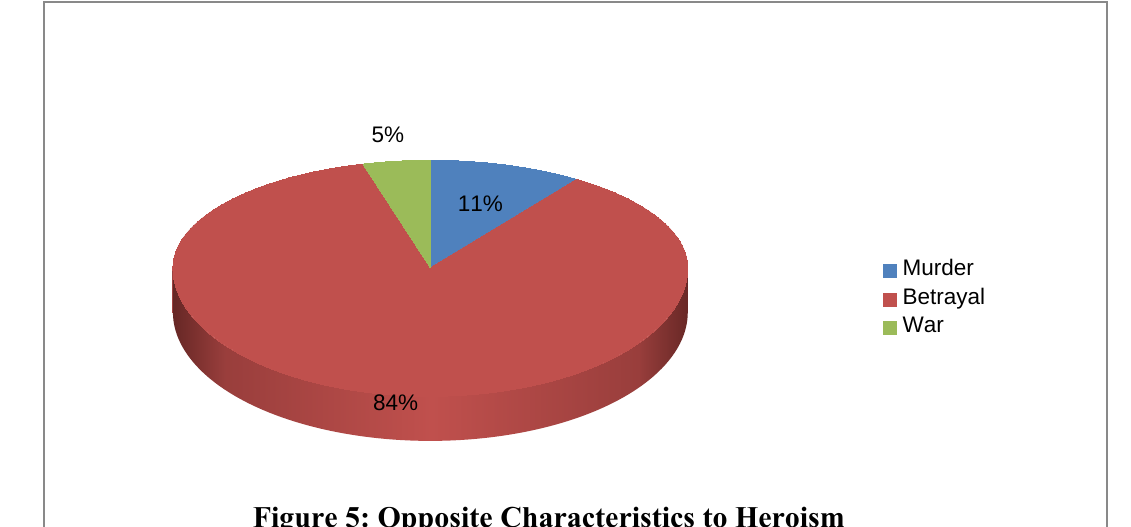
Figure 5: Opposite Characteristics to Heroism